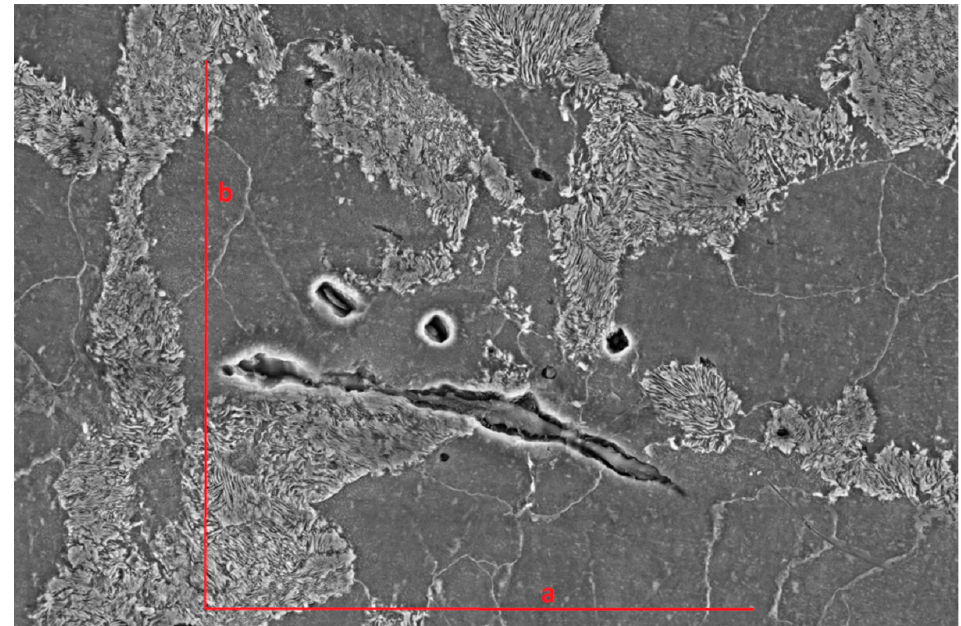
Figure A6. Account length of the selected area used to calculate mesoscale plane-strain for the tensile specimen (11K).